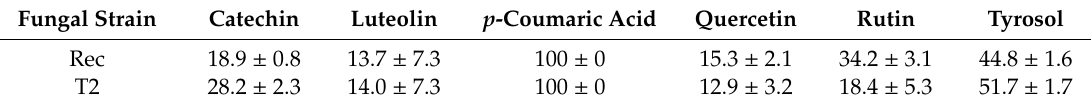
Table 3. Percentage inhibition of fungal growth two weeks after V. nonalfalfae inoculation on PDA plates supplemented with phenolic compound.